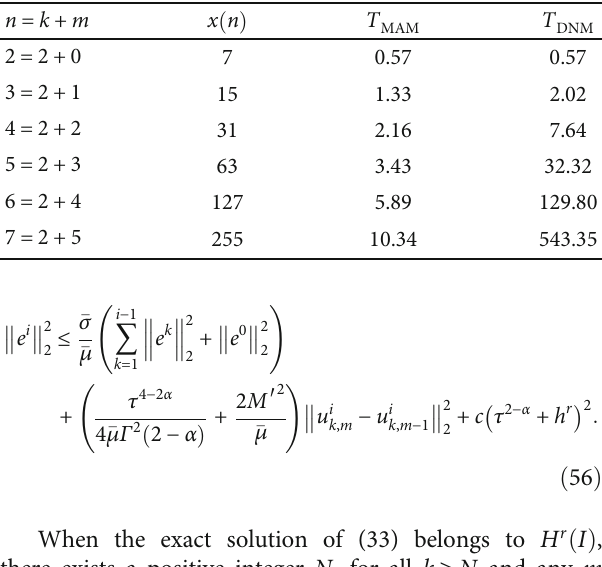
Table 9: Comparison of CPU time between MAM and DNM with k = 2, τ = 0 : 005 , and α = 0 : 1 for Example